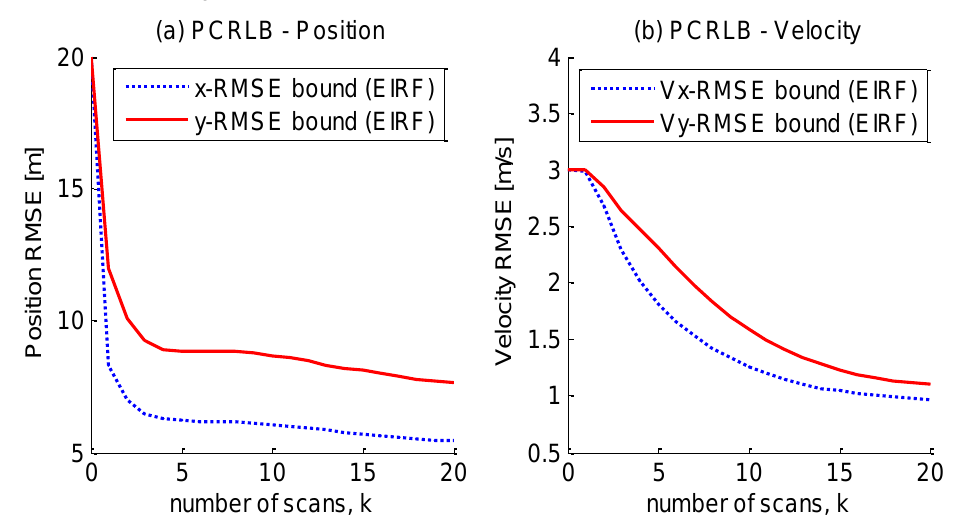
PCRLB curves of the multi-measurement extended target tracking for (a) the target position in the directions of the x and y axes and (b) the target velocity in the directions of the x and y axes.